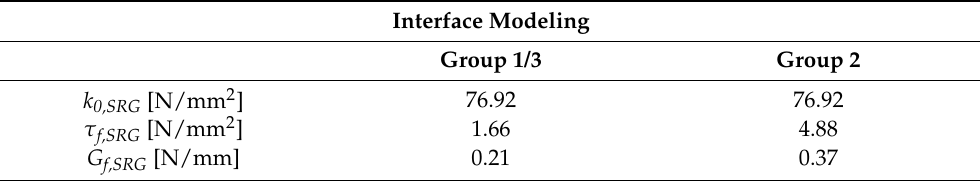
Table 5. Lu’s parameter values.